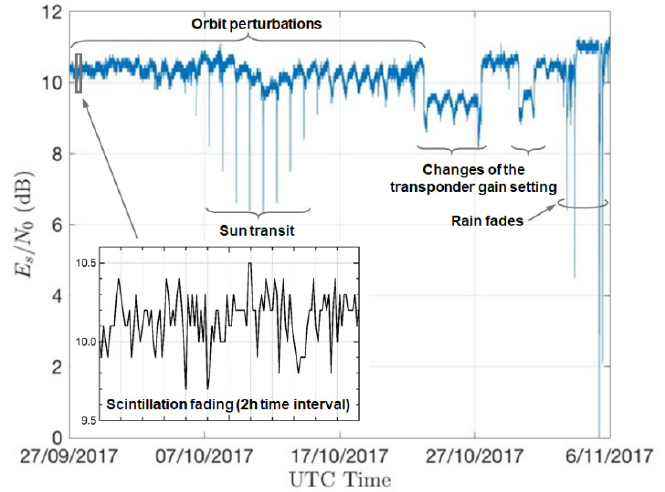
Figure 3. Record of received E s / N 0 from the GEO satellite downlink described in Table 3 over a 6 week interval.